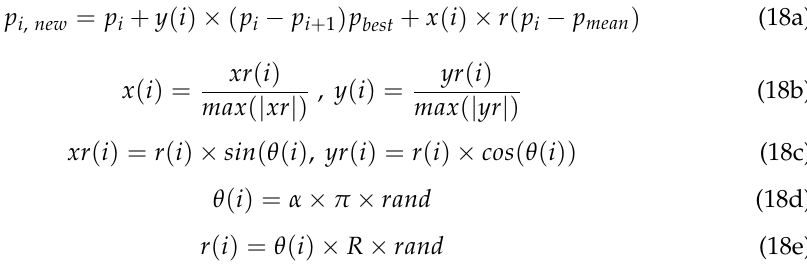
Figure 7. ( a ) Behavior of bald eagle during hunting; ( b ) sequential stages of bald eagle hunting.